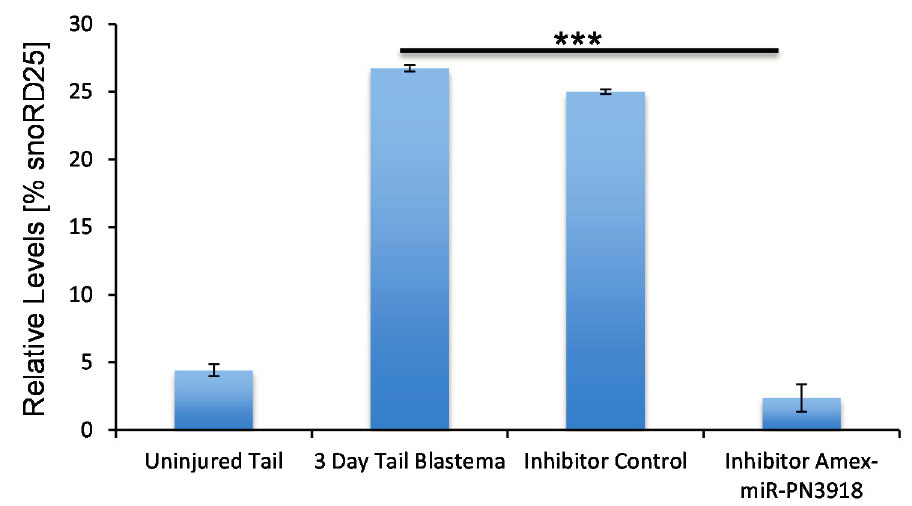
Figure 5. Quantitative RT-PCR analyses confirmed that the Amex-miR-pn3918 inhibitor significantly reduced the levels of Amex-miR-pn3918 in the three-day blastema. ( *** p <